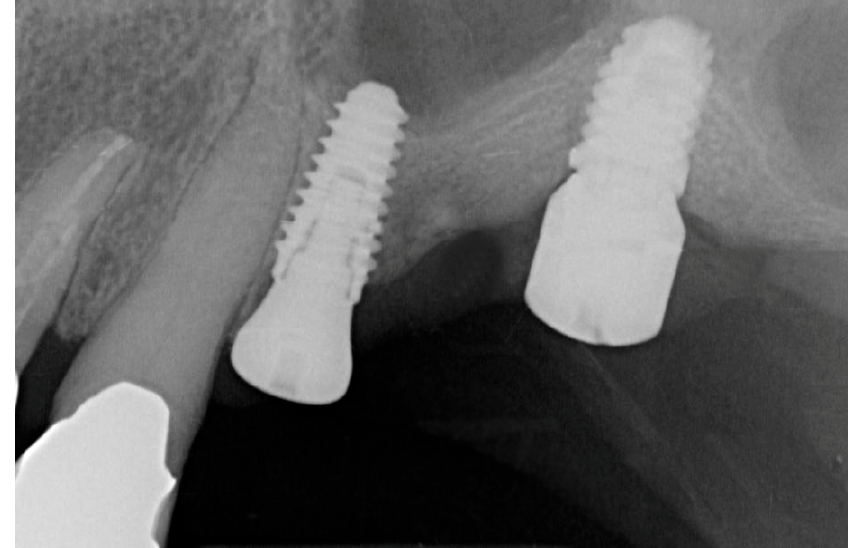
Figure 2. A new implant was inserted in the bed prepared by 3-mm trephine.